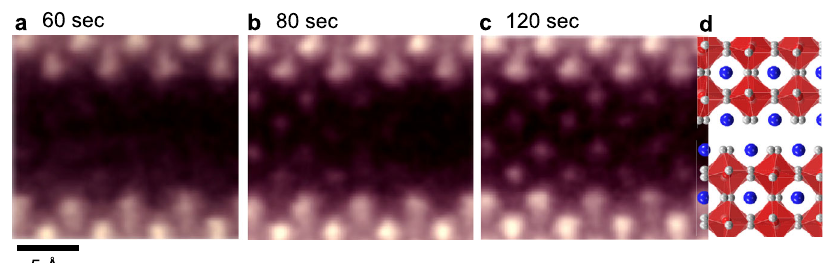
Fig. 8 | Recrystallization of a premelted amorphous layer. a − c These HAADF images were captured from the video clip (Supplementary Movie 1) recorded duringe-beamirradiationat60( a ),80( b ),and120s( c )inSTEM.Theregeneration